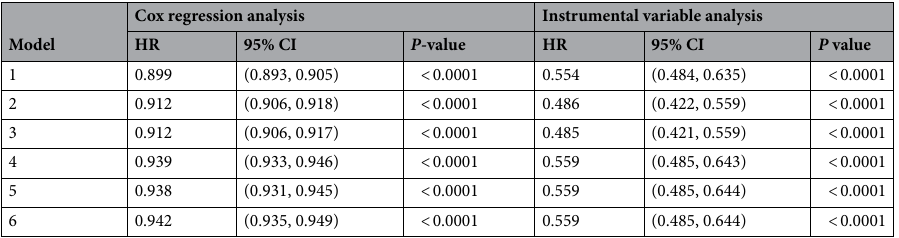
Table 2. Cox regression analysis for the risk of mortality. Model 1: TCO 2 only. Model 2: Model 1 + sex, age, history of hypertension and diabetes. Model 3: Model 2 + usage of sodium bicarbonate. Model 4: Model 2 + baseline kidney function as MDRD-GFR. Model 5: Model 4 + usage of sodium bicarbonate. Model 6: Model 5 + RAAS blockades + Diuretics group. CI confidence interval, ESRD end-stage renal disease, GFR glomerular filtration rate, HR hazard ratio, MDRD modification of diet in renal disease, TCO 2 total CO 2 .